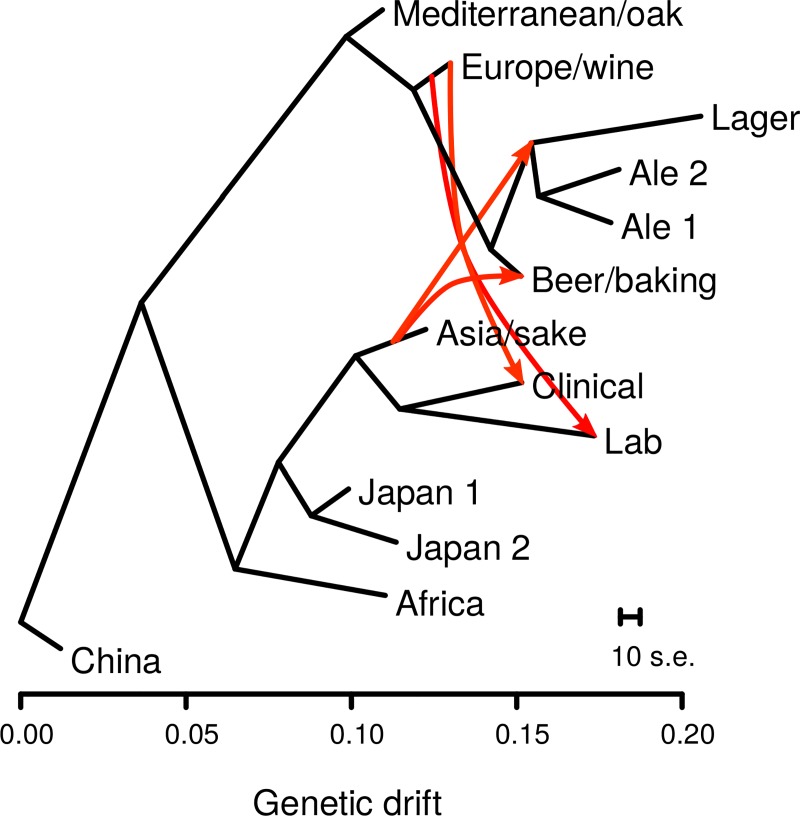
Admixture graph of population relationships shows admixture from the Asia/sake to multiple beer populations.Population relationships were inferred using TreeMix, and horizontal branch lengths are proportional to genetic drift with the scale bar showing the average of 10 s.e. of the sample covariance matrix. Red arrows show admixture events with migration weights over 0.40, indicating the fraction of alleles derived from a source population. Migration from the ancestor of the Mediterranean/oak to the Clinical population is not shown for clarity. The data underlying this figure are available from http://doi.org/10.6084/m9.figshare.7550009.v1. s.e., standard errors.